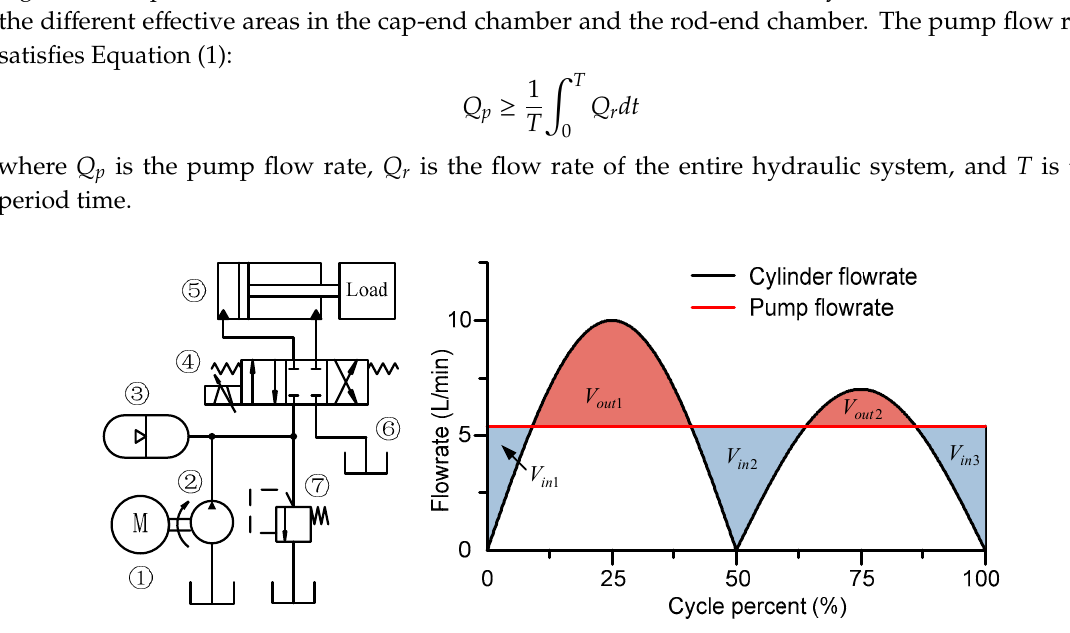
Figure 1. The flow rate of the cylinder and the pump in a single cylinder hydraulic system: (1) motor; (2) fixed displacement pump; (3) hydraulic accumulator; (4) proportional valve; (5) cylinder; (6) tank; (7) relief valve.